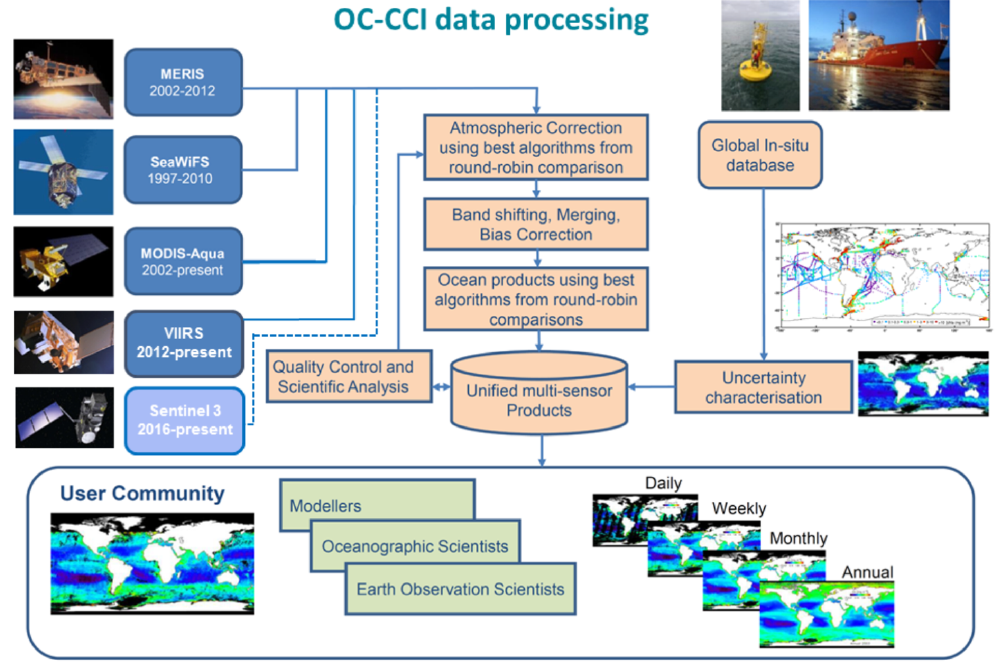
Figure 5. Schematic diagram illustrating the main steps in the processing chain implemented for OC-CCI: Note that VIIRS data were added to the input data stream from v3 onwards. Inclusion